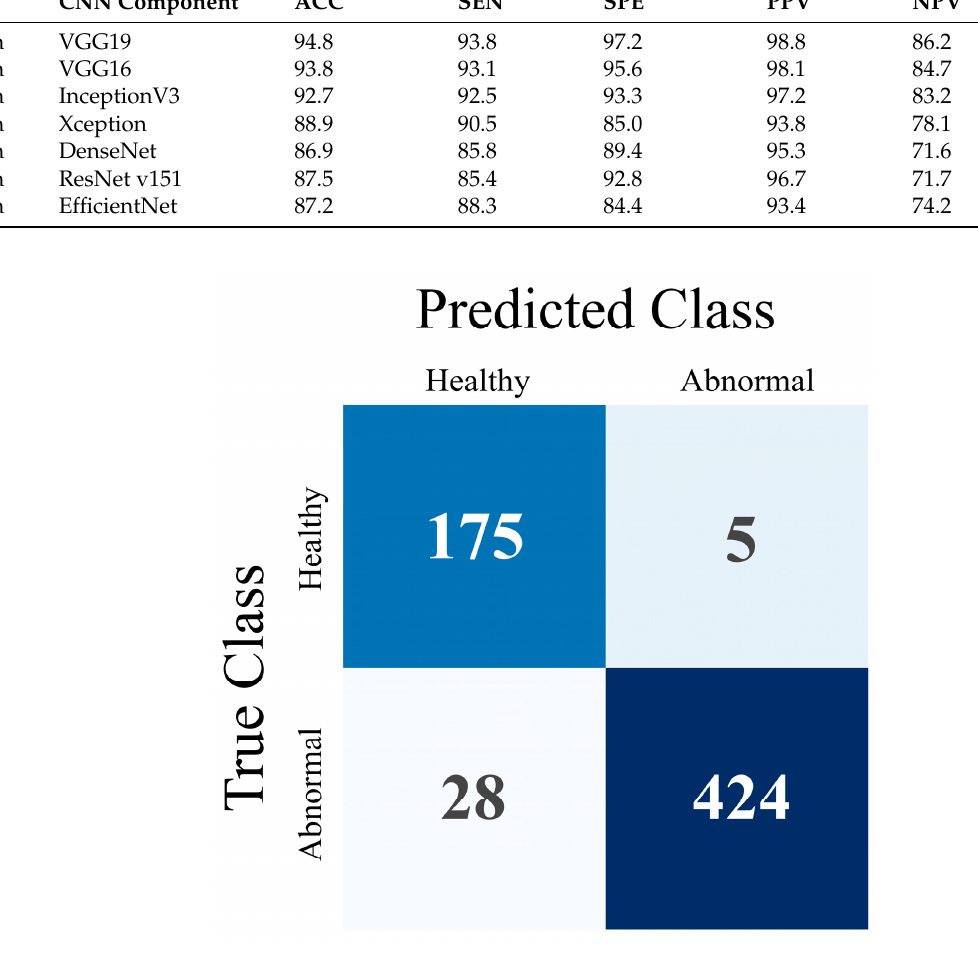
Figure 4. Confusion Matrix for patient-level evaluation.